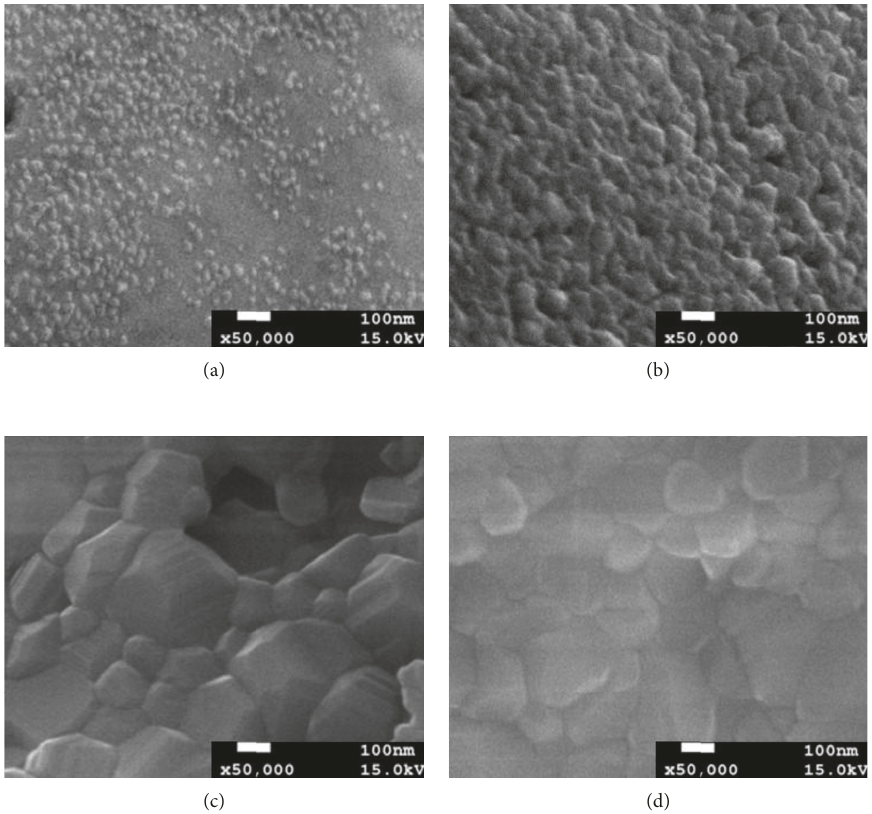
Figure 4: SEM image ( × 50,000) of (a) 400 ° C sol, (b) 400 ° C gel, (c) 800 ° C sol, and (d) 800 ° C gel.